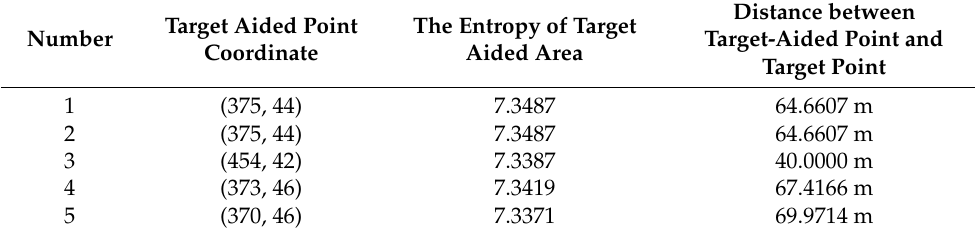
Table 4. Simulation results of target aided points search in case study 1.